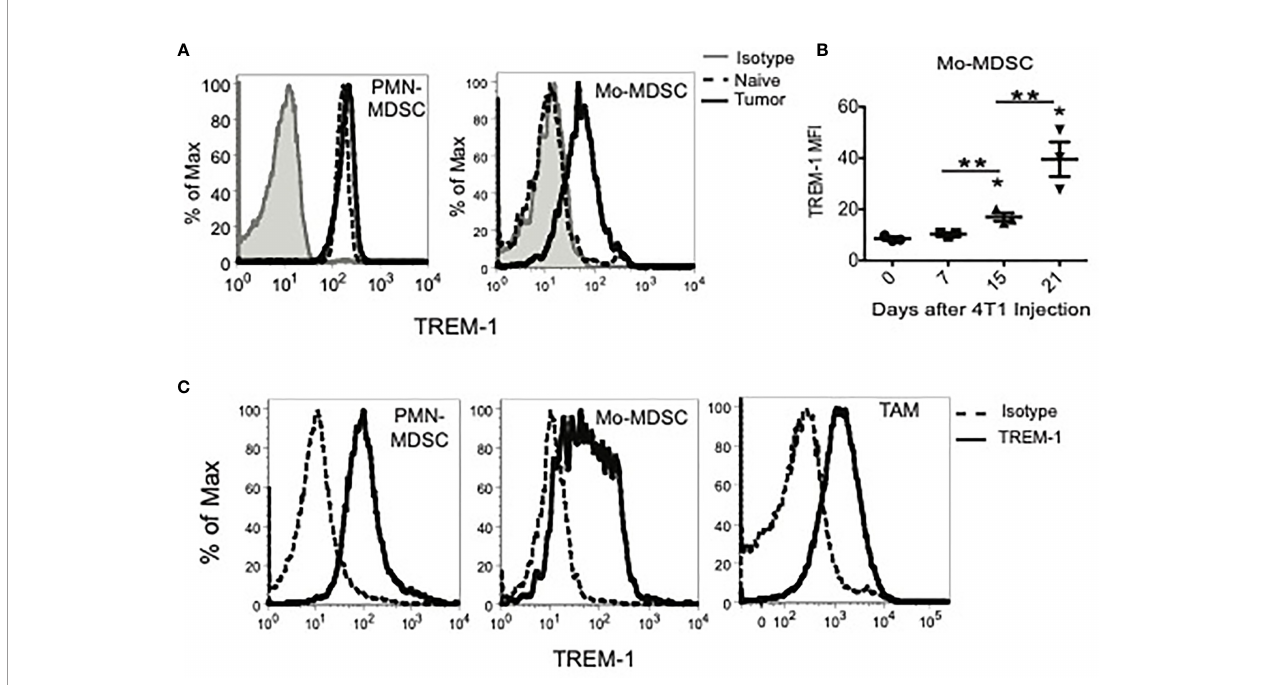
FIGURE 1 | TREM-1 is expressed on peripheral myeloid-derived suppressor cells (MDSC) subsets, tumor-in fi ltrating MDSC, and tumor-associated macrophages in tumor-bearing mice. (A) TREM-1 expression on splenic granulocytic MDSC (PMN-MDSC) and monocytic MDSC (Mo-MDSC) from naïve or tumor-bearing mice 21 days after 4T1 inoculation. (B) TREM-1 levels on tumor-derived Mo-MDSC 0, 7, 15, and 21 days after the 4T1 tumor challenge. * p < 0.05 relative to naïve mice, ** p < 0.0. (C) TREM-1 expression on PMN-MDSC, Mo-MDSC, and tumor-associated macrophages isolated from tumors of tumor-bearing mice 21 days after 4T1 injection. One representative histogram is shown for each population out of more than three independent